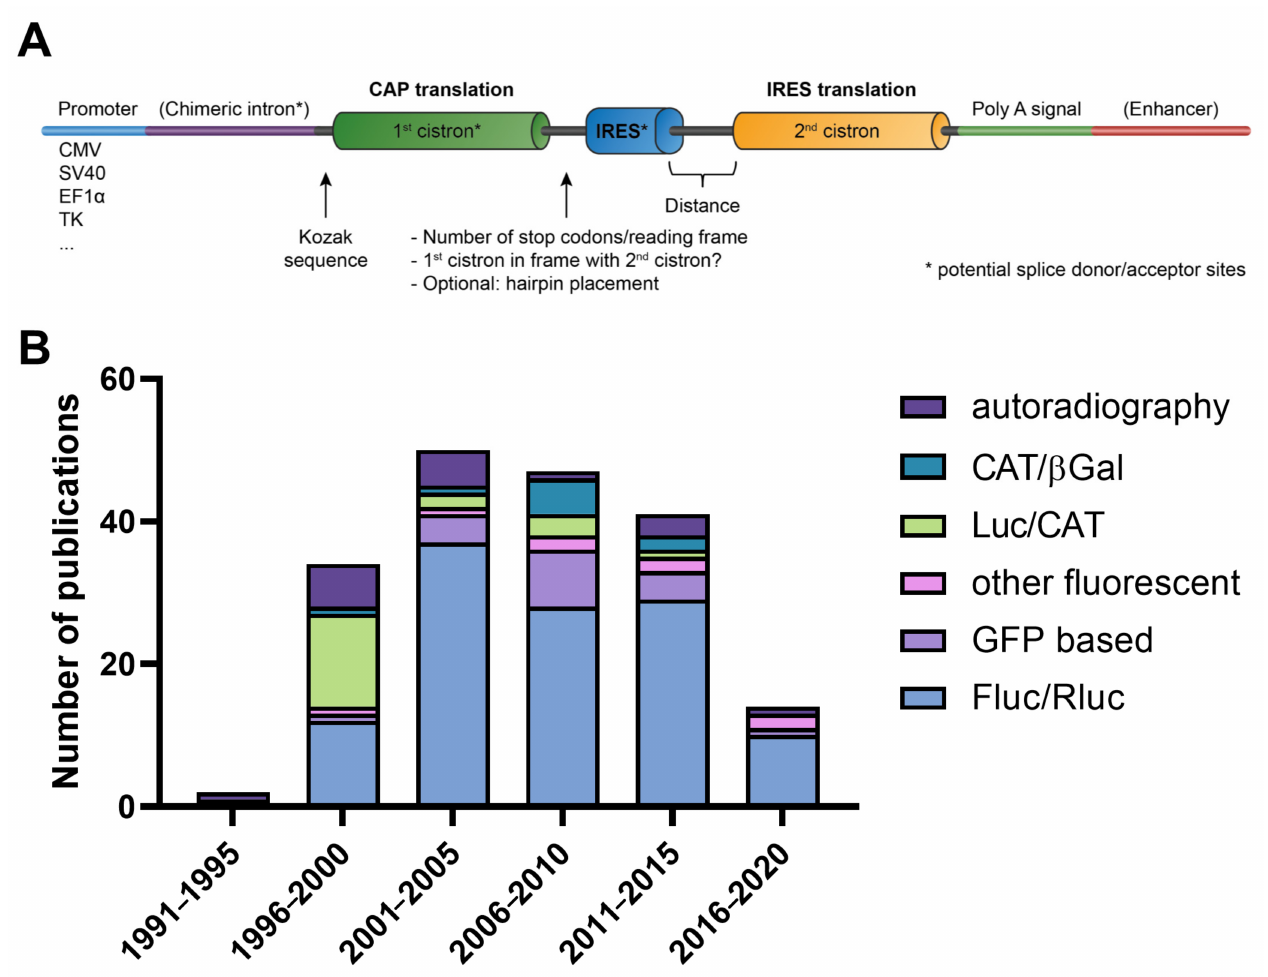
Figure 2. Bicistronic reporter design considerations and reporter gene use over time. ( A ) Relevant reporter design parameters are depicted. The choice of promoter and use of a chimeric intron and/or enhancer alters the mRNA expression levels, stability, and translation efficiency. The reporter genes themselves, as well as their positioning, can influence the observed IRES activity. The exact IRES sequence, for example EMCV sequence variants, can also have large effects. Potential read-through can be inhibited with (multiple) stop codons behind the first cistron (in all three reading frames) or inclusion of an inhibitory hairpin (second arrow). The first cistron always contains a Kozak sequence, but in some specific plasmid backbones, we identified a second Kozak sequence at the second cistron. A common criticism on the bicistronic reporter assay is the possibility of cryptic splicing due to specific reporter element ( * ) or cryptic promoter activity of the IRES sequence that can lead to false positive results. The former can be evaluated with Northern blot, RT-PCR, or 5 (cid:48) -RACE and ruled out with a monocistronic reporters or a cell-free translation system; the latter can be ruled out by using promotorless control constructs or a cell-free translation system. Cryptic promoter activity can be reduced with SPA sites, although this can lead new cryptic splicing events. ( B ) Reporter gene configuration was summarized by allocation to six functional groups in five-year bins. The first publication was from 1994, which explained the low number of publications in the first bin. β Gal = β -galactosidase, CAT = chloramphenicol acetyl transferase, Luc = any luminescent protein, GFP = green fluorescent protein, Fluc = Firefly luciferase, Rluc = Renilla